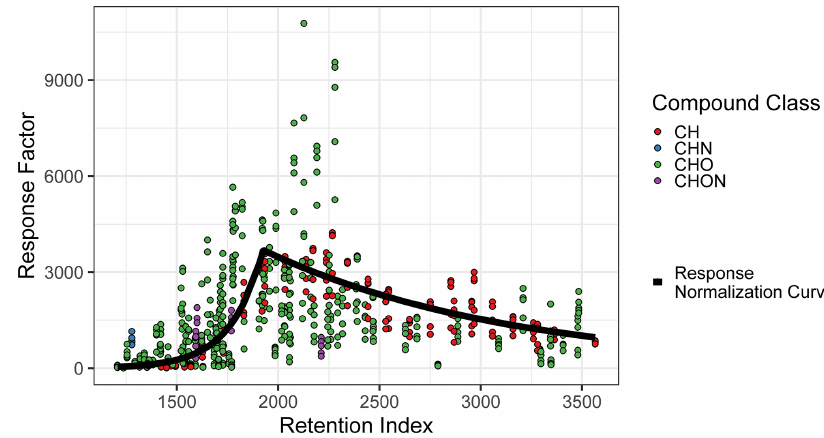
Figure A2. Quantification factor normalization curve, based on the average response factors of alkanes.